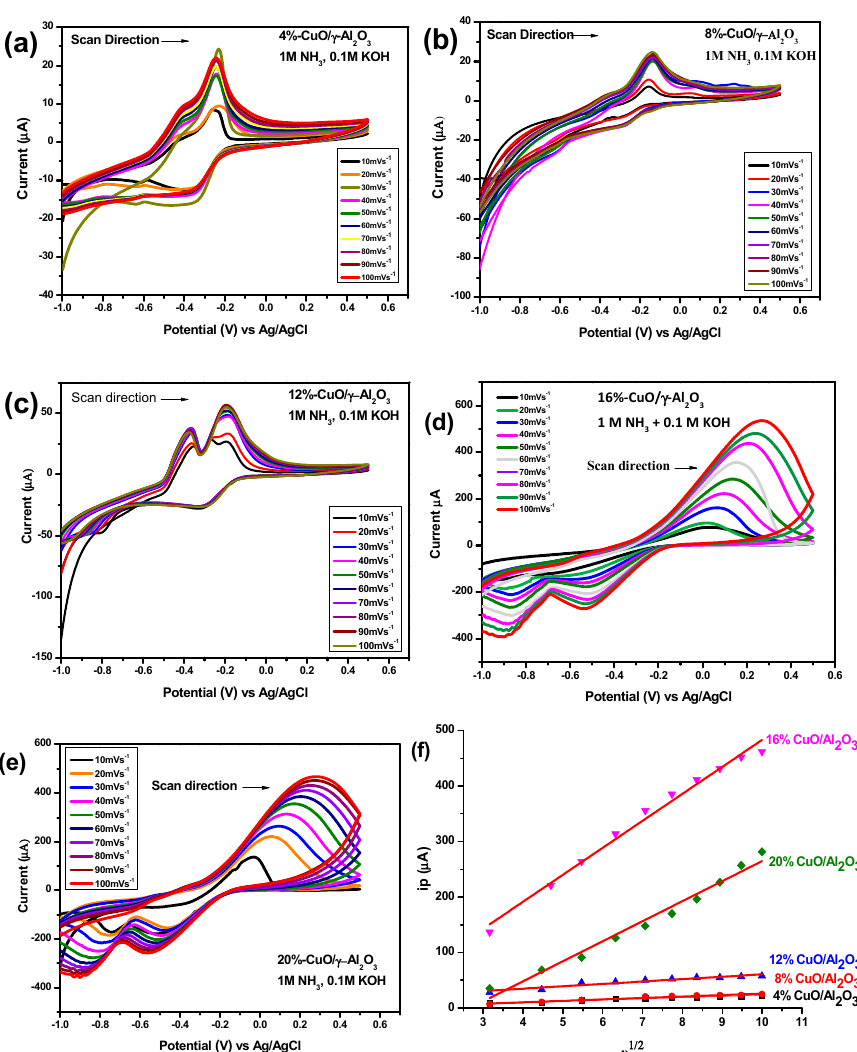
Figure 7. Cyclic voltammograms for 4%–20%-CuO/ γ -Al 2 O 3 recorded in (1.0 M NH 3 + 0.1 M KOH) solution; scan rate from 10–100 mV·s − 1 ( a – e ) and Randles-Sevcik plots derived from cyclic voltammetry (CV) curves of each catalyst ( f ).